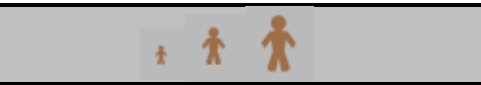
Figure 9 . Initial Child, Sibling, and